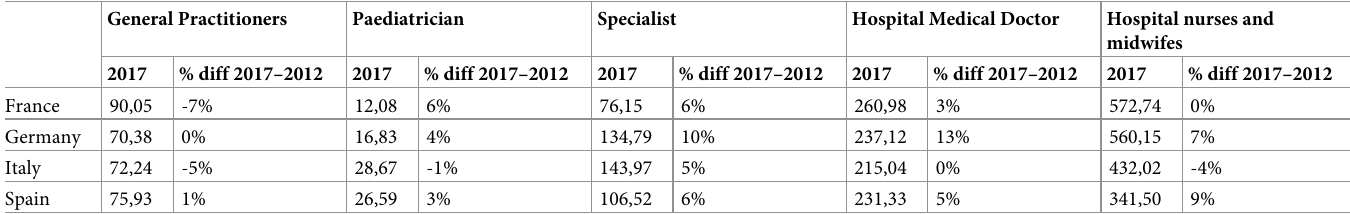
Table 2. Health personnel per 100.000 inhabitants in 2017 and variation with 2012. General Practitioners